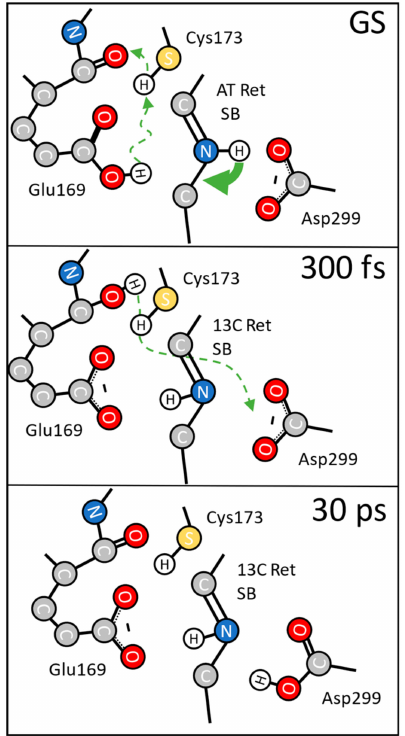
Figure 5. Proposed reaction scheme for the protein response after photoexcitation. In the ground state (GS) Glu169 is protonated. Upon excitation the retinal isomerizes within 100 fs (green arrow) and induces deprotonation of Glu169 (green dashed arrow); the proton is transferred to the nearby backbone CO-group of Glu169 itself; the SH group of Cys173 may be involved. At 300 fs the photoproduct is formed with the Schi ff base NH group pointing in a di ff erent direction; we have deprotonated carboxylate groups of Glu169, and Asp299; the backbone CO group of Glu169 is protonated. With a decay time of 16 ps the proton at the backbone CO group of Glu169 is transferred to Asp299. At 30 ps Glu169 is deprotonated, while Asp299 is